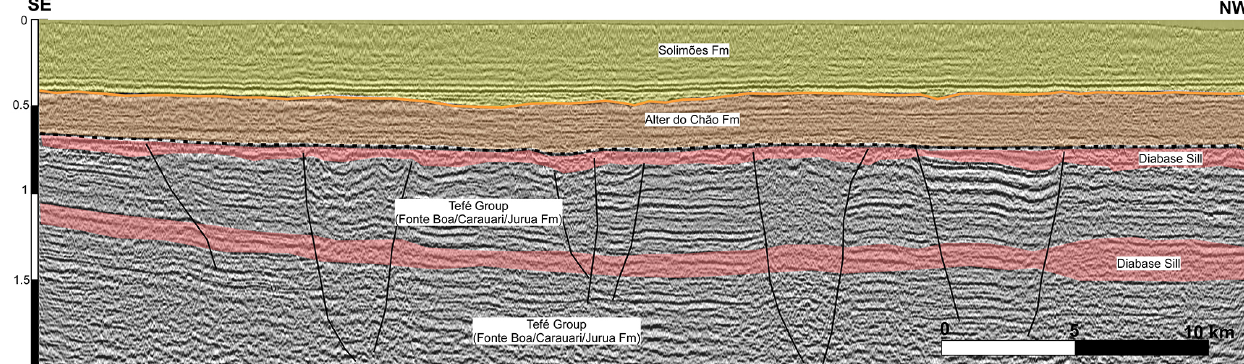
Figure 3. Seismic reflection profile from the Solimões Basin (location of line shown in Fig. 1). Here, the Alter do Chão Formation is illustrated to be Cenozoic (Caputo, 2011), not Cretaceous, as previously believed. Multiple diabase sills and interbedded sediments uncon- formably underlie Cenozoic sediments in this region. The proposed (SB) drill hole will encounter the same stratigraphic column as shown in the seismic line, but is located more accessibly on the Rio